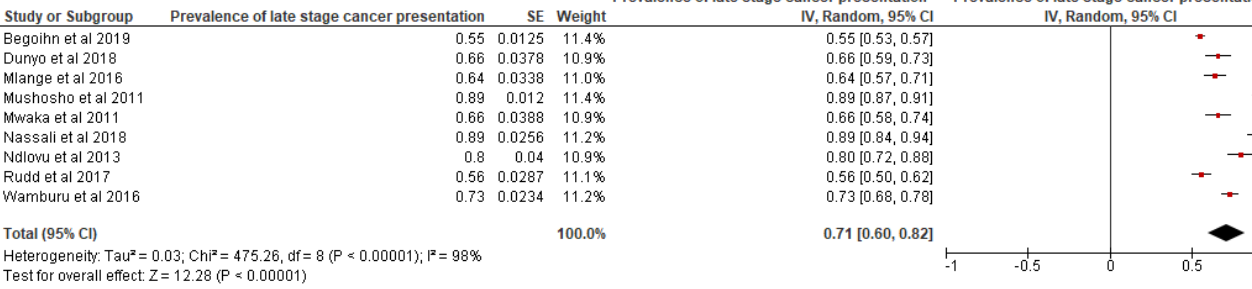
Figure 6. Prevalence of late-stage cancer presentation at diagnosis. Source: